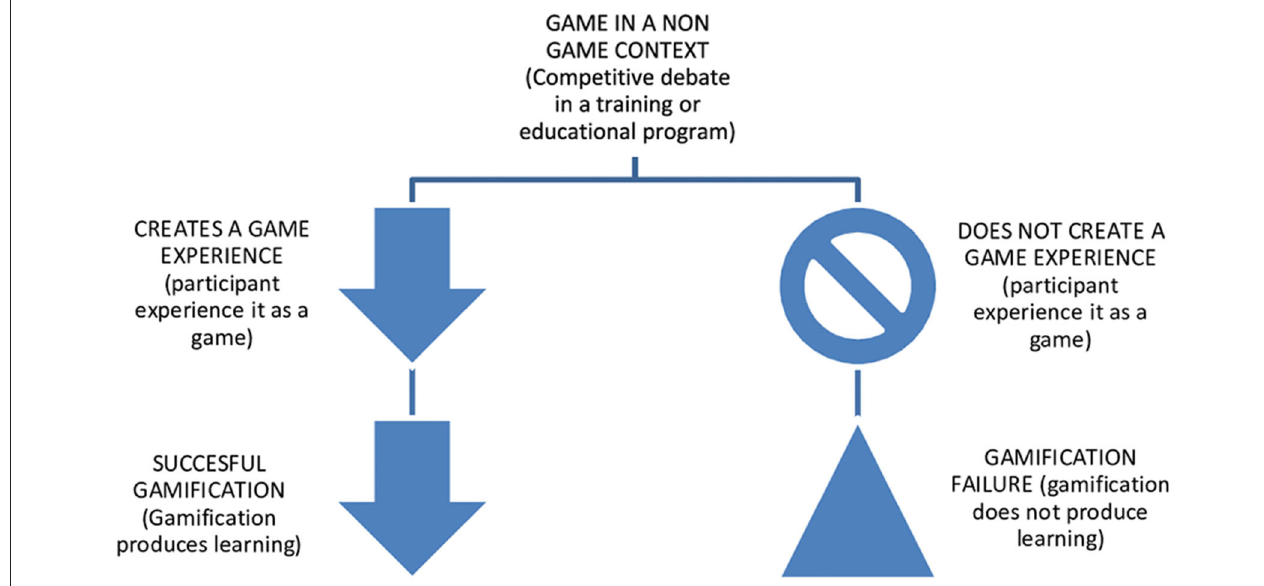
FIGURE 1 | Relationship flowchart between game, game experience and gamfication for learning. Source : Own